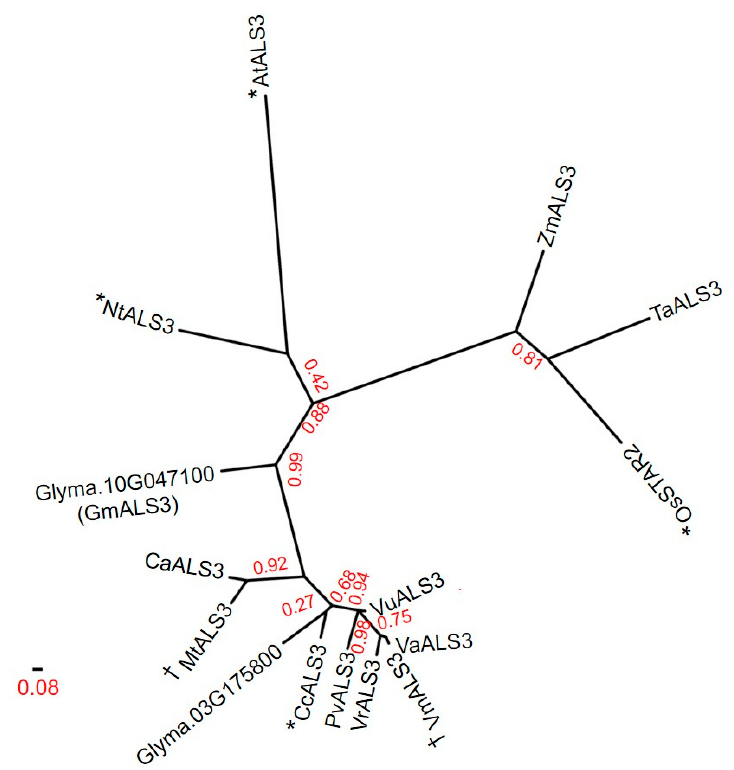
Figure 4. Protein sequences having ≥ 75% sequence identity with GmALS3. A phylogenetic tree was generated using Phylogeny.fr. Branch-support values were calculated using the bootstrapping procedure indicated in red. The tree was constructed from a sequence alignment of the following proteins: Arabidopsis thaliana AtALS3 (GenBank: OAP08021), Nicotiana tabacum NtALS3